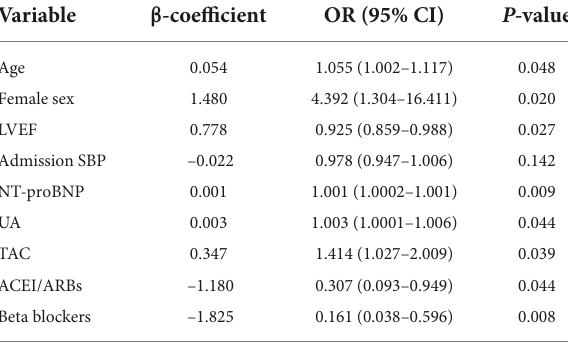
TABLE 3 Predictive model for post-discharge mortality based on stepwise generalized linear